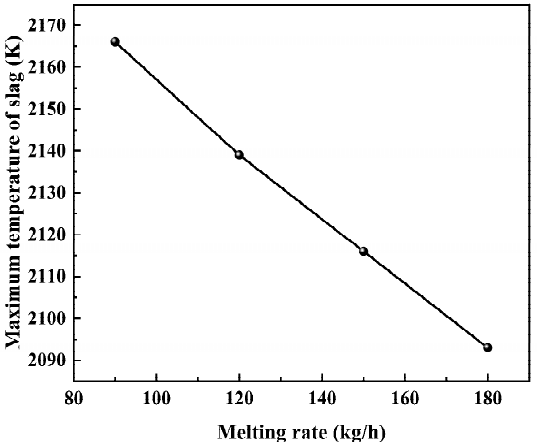
Figure 2. Effect of melting rate on maximum slag temperature.